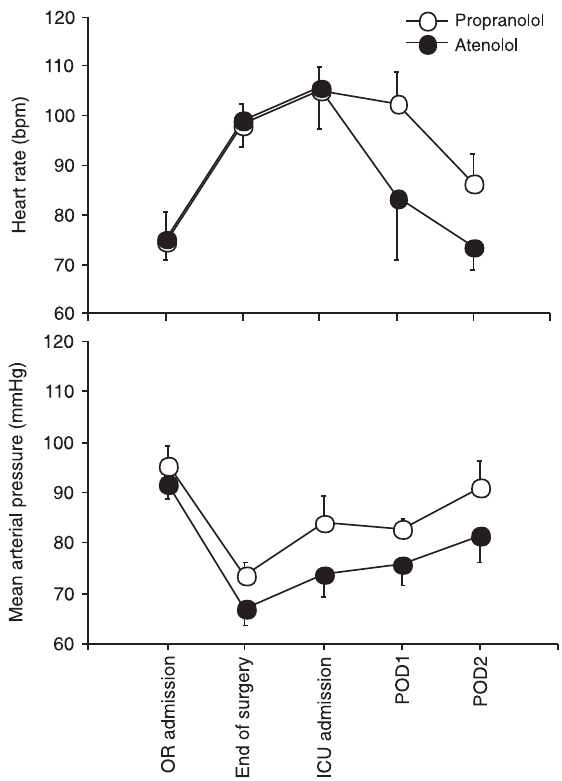
Figure 1. Heart rate and arterial pressure of patients receiving atenolol and propranolol. The patients received atenolol (filled circles, N = 8) or propranolol (open circles, N = 11). OR = operating room; ICU = intensive care unit. POD1 and POD2 = postoperative days 1 and 2,